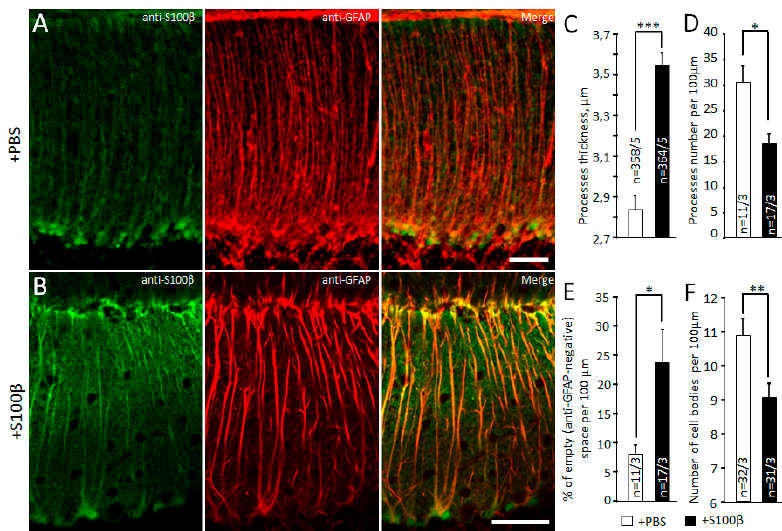
Figure 2. S100 β alters morphology of Bergmann glia. Microphotographs show anti-S100 β and anti-GFAP immunoreactivity in injected areas from PBS ( A ) and S100 β ( B ) treated mice. Scale bar 50 µ m. ( C ) Summary graph showing the thickness of BG processes in µ m; *** p < 0.001. ( D ) In comparison with PBS injected areas, there were significantly fewer BG processes per 100 µ in S100 β injected areas; * p < 0.05. ( E ) BG processes were sparser in S100 β injected areas; * p < 0.05. ( F ) Reduction in BG cell bodies caused by S100 β ; ** p < 0.01.